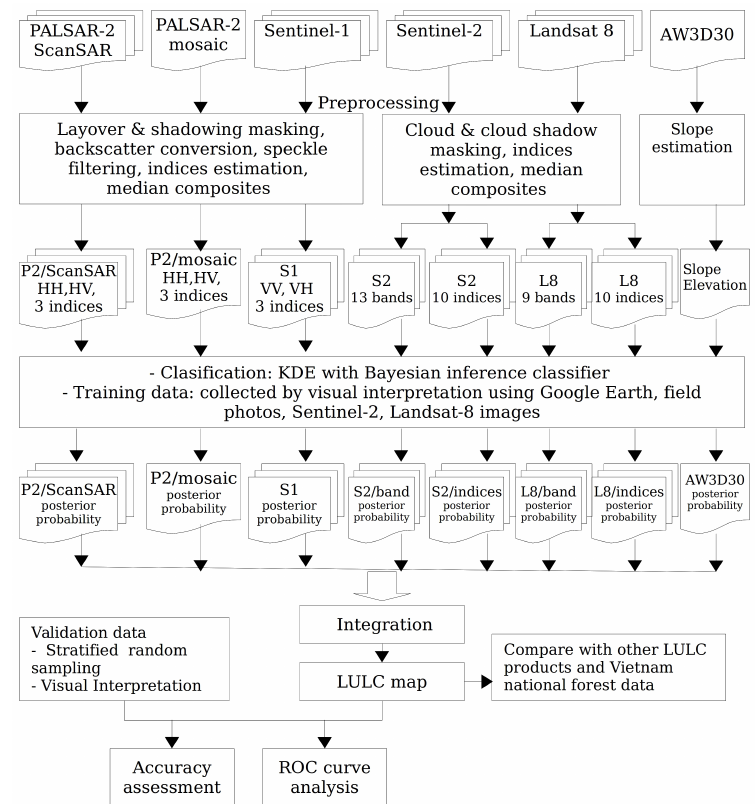
Figure 2. The overall workflow of establishing the high-resolution land use / land cover (LULC) map for